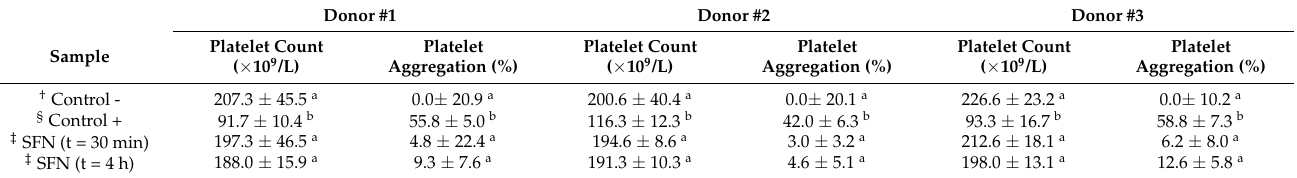
Table 3. Effect of SFN on platelet aggregation assessed by incubation in PRP.